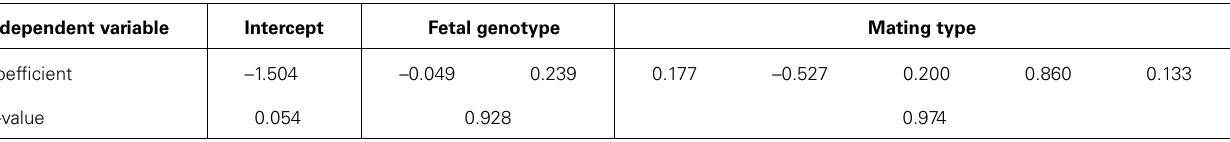
Table 1 | Results from logistic regression for SNP rs9930506 from data with only the first child in each family. Independent